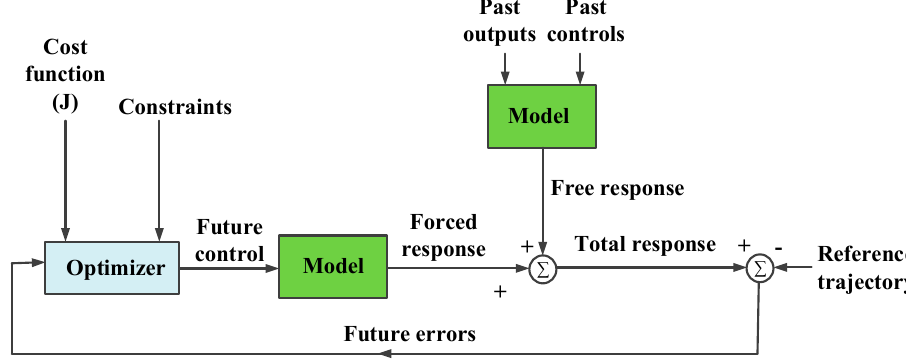
Figure 5. The main structure of the model predictive control (MPC)